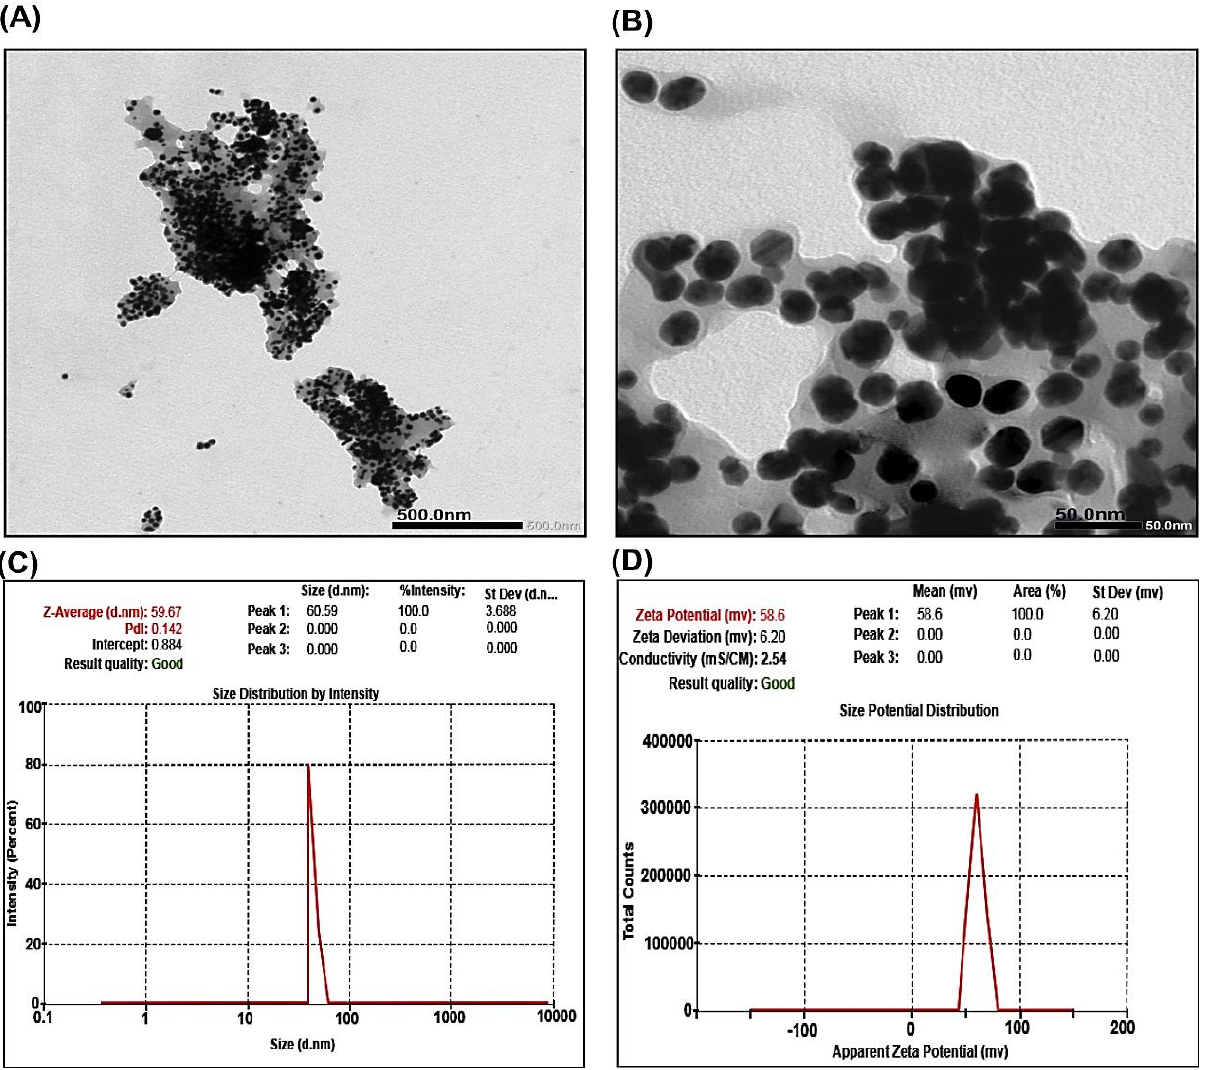
Figure 1. Transmission electron microscopy images of CNPs: ( A , B ) average particle size around 50 ± 5 nm; ( C ) particle size distribution of CNPs assessed by dynamic light scattering (DLS) at 59.67 nm; ( D ) zeta potential distribution of CNPs by dynamic light scattering (DLS) shows positive charge at +58.6 mV.